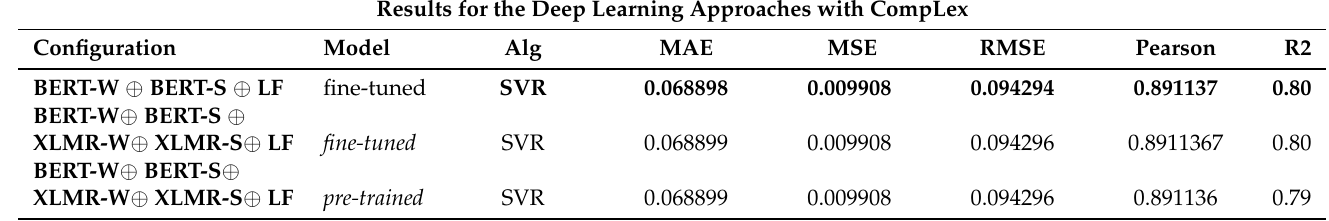
Table 4. Results for different feature combinations, models, and